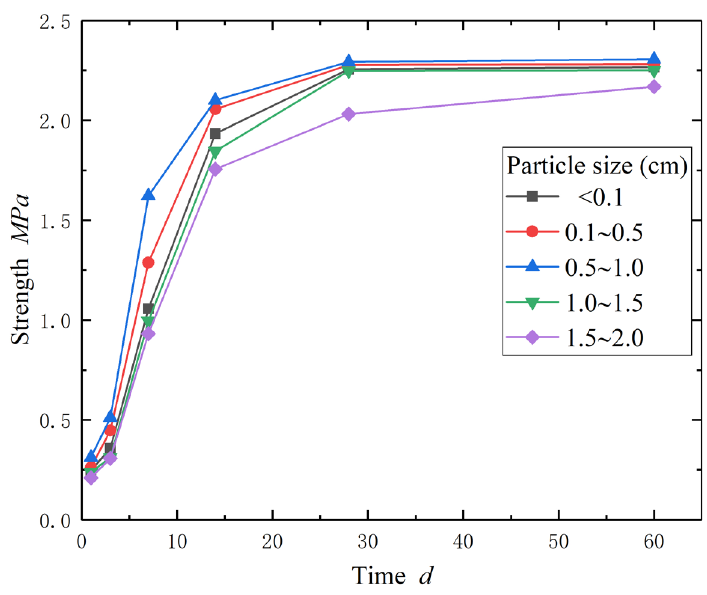
Figure 3. Compressive strength versus time curves for samples with different particle sizes.